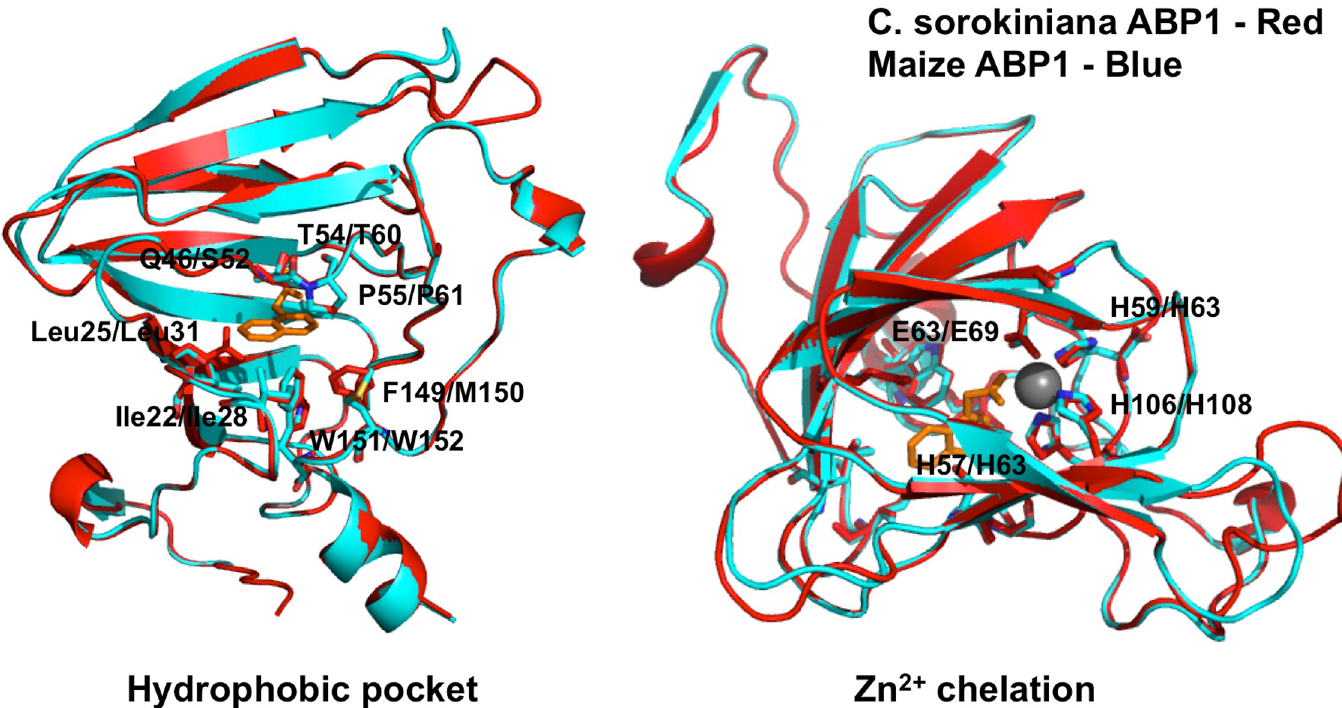
Fig 6. Multiple sequence and structural alignment reveal a high degree of structural conservation between Z . mays ABP1 and C . sorokiniana ABP1. A SWISSMODEL structural alignment on automated mode aligned CsABP1 with the ZmaABP1 crystal structure co-crystallized with the synthetic auxin naphthalenacetic acid (NAA). The resulting model revealed almost complete conservation of the auxin binding pocket (A) , and complete conservation of the histidines and and glutamic acid residues that coordinate the zinc atom (B) that stabilizes the carboxylate moiety of IAA/NAA. The red structure represents Zea mays , and the blue structure represents Chlorella sorokiniana . Z . mays residues are indicated first, with C . sorokiniana residues following the slash.